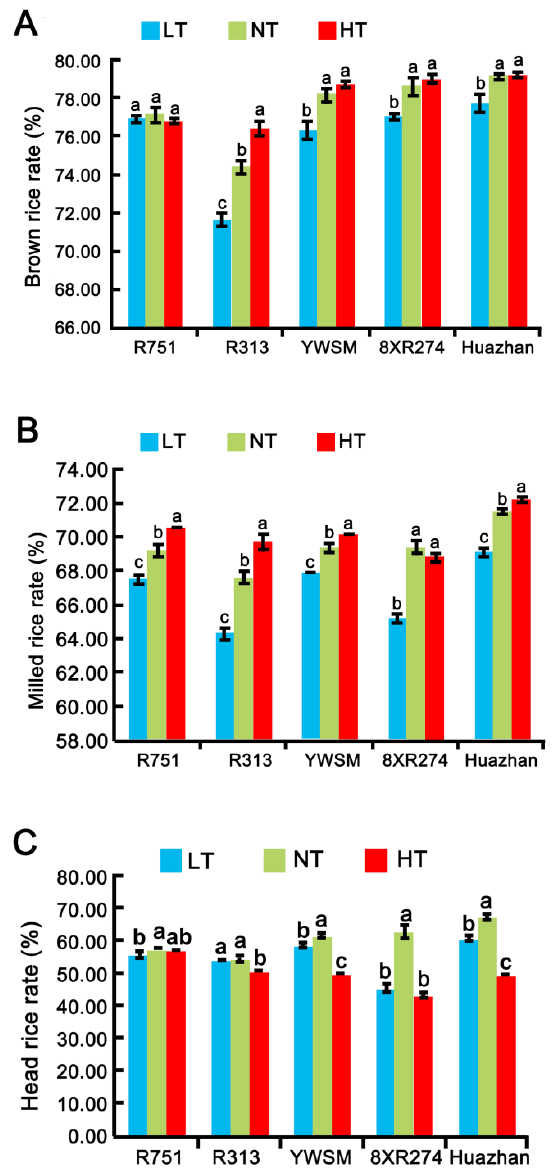
Figure 1. Brown rice rates ( A ), milled rice rates ( B ), and head rice rates ( C ) of different rice varieties affected by improper temperature at the grain-filling stage. LT represents low temperature; HT represents high temperature; NT represents normal temperature control. Data are shown as mean ± standard error of triplicate measurements. Different letters are marked above standard deviations to express significant differences ( p < 0.05).